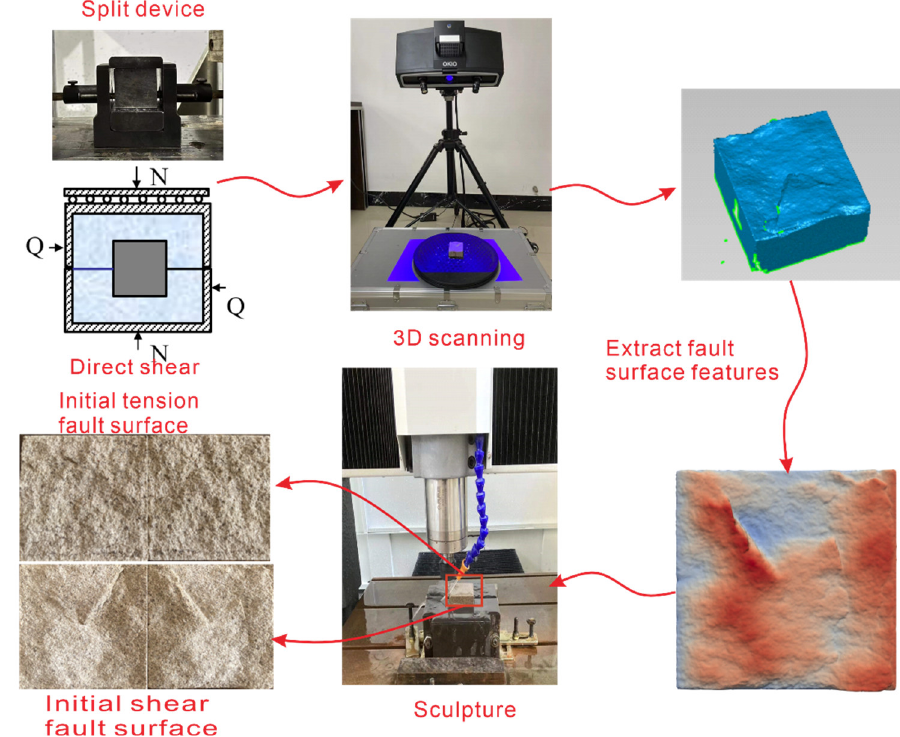
Figure 4. Fault plane re-engraving flow chart.